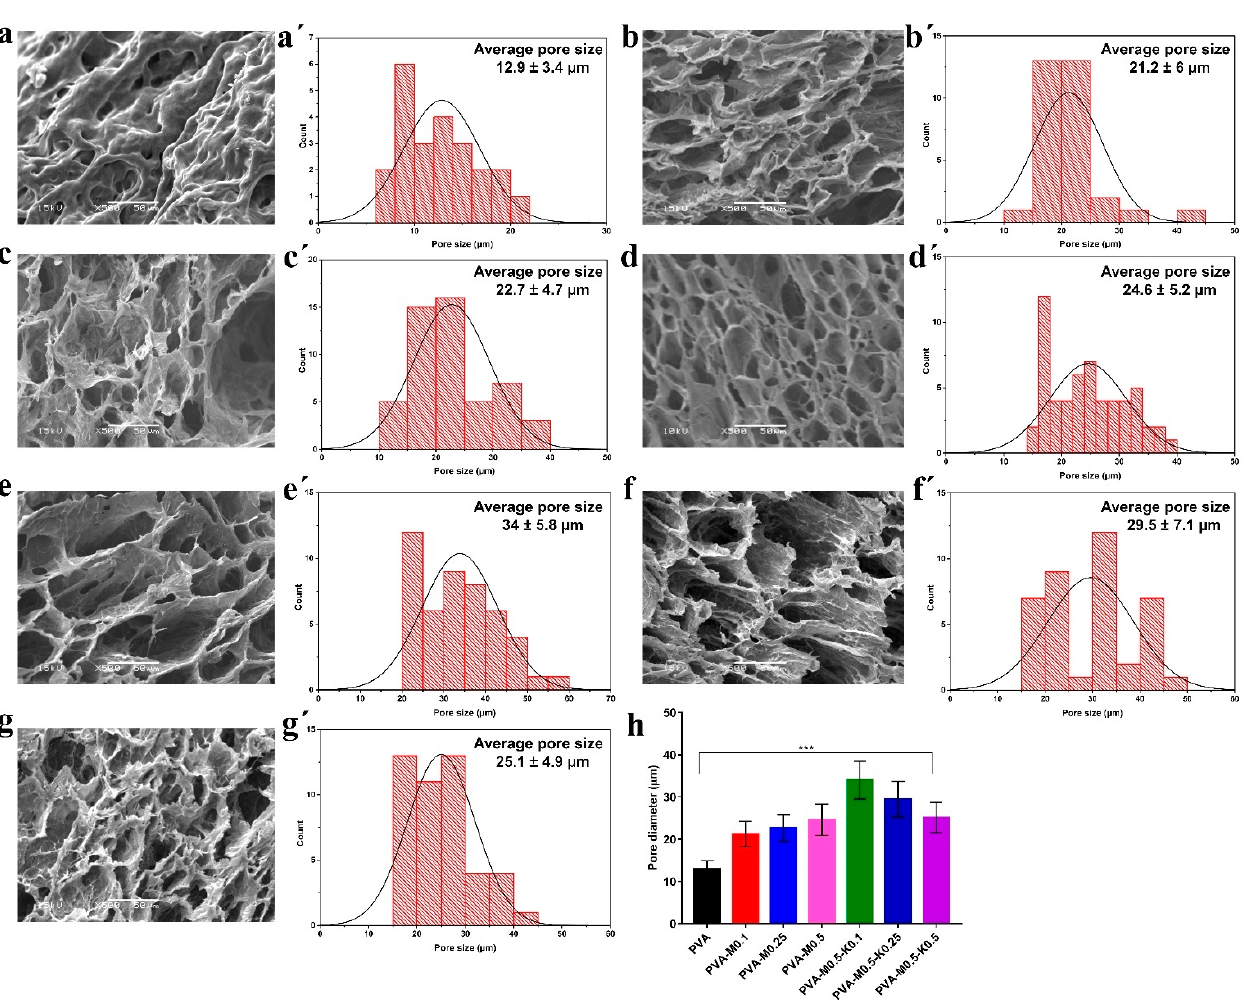
Figure 4. SEM images show cross-sectional and porous structures ( a ) PVA, ( b ) PVA-M0.1, ( c ) PVA-M0.25, ( d ) PVA-M0.5, ( e ) PVA-M0.5-K0.1, ( f ) PVA-M0.5-K0.25, and ( g ) PVA-M0.5-K0.5 composite sponges at a magnification of 500×. ( a ’– g ’ ) illustrates the pore size distribution of PVA, PVA-M0.1, PVA-M0.25, PVA-M0.5, PVA-M0.5-K0.1, PVA-M0.5-K0.25, and PVA-M0.5-K0.5 composite sponges, respectively. ( h ) indicates the size of the average pores of PVA, PVA/marjoram, and PVA/marjoram/kaolin sponges. Results are presented as means ± SD (*** p < 0.001).